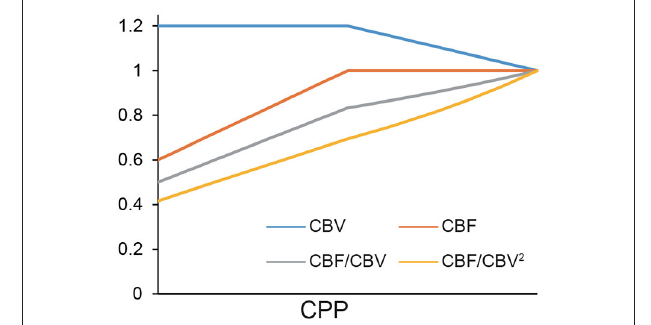
FIGURE 2 | A simulation of CBF/CBV and CBF/CBV 2